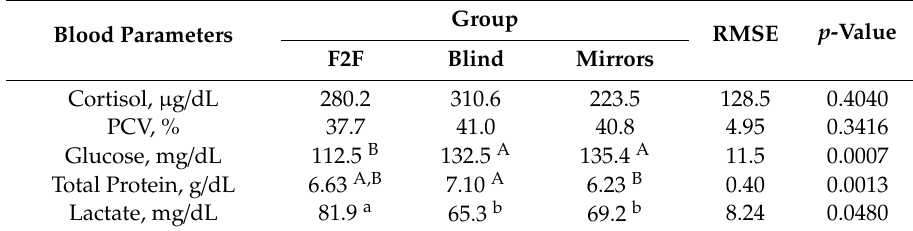
Table 2. Cortisol and secondary stress markers.